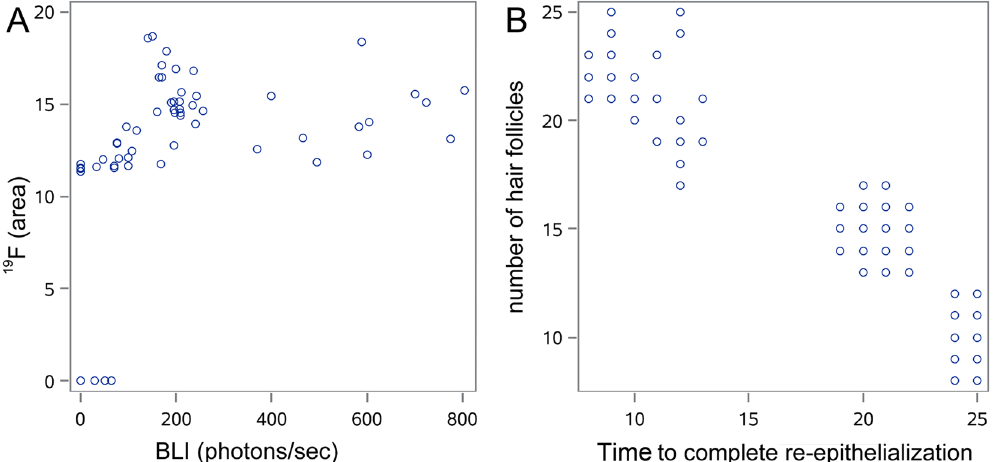
Figure 8. Correlational analyses. Correlation of BLI and 19 F signal loss ( A ) and correlation of in vivo and post mortem outcome measures ( B